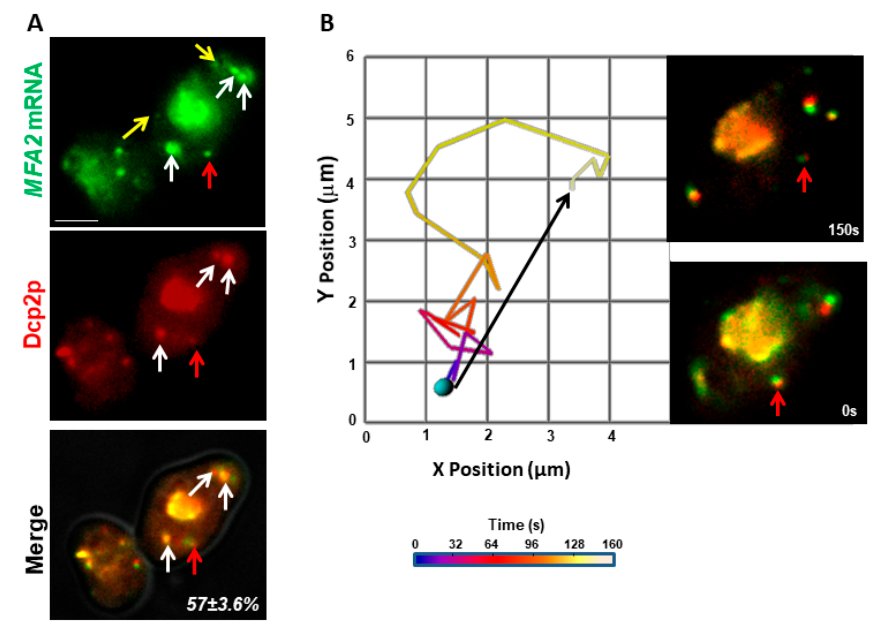
Figure 7. MFA2 mRNA and the PB marker co-transported to the shmoo tip. ( A ) MFA2 mRNA (green) co-localized with Dcp2p-RFP (red), a PB marker, in many granules. Several small co-labeled granules are indicated by the red and white arrows, while granules with MFA2 alone are marked by yellow arrows. Scale bar = 5 µm. ( B ) The 2D track is shown for the granule in ( A ) indicated by the red arrow. The track displacement of this translocational granule (black arrow) over an observation period spanning 150 s, was 3.8 µm. Inset: the two markers remained co-localized during the entire track.